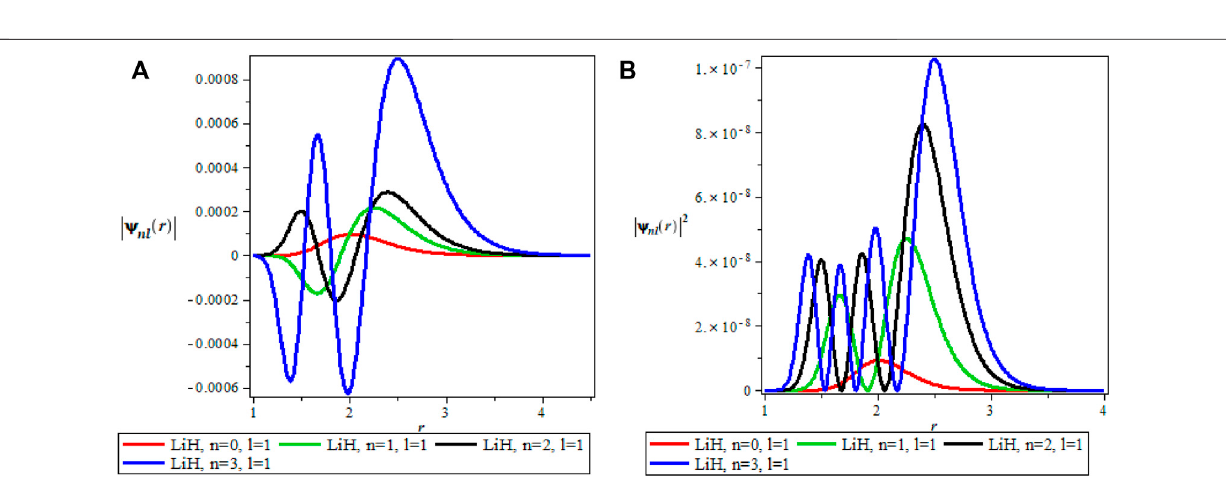
FIGURE 2 | (A) Wavefunction plot for fi xed l = 1 for LiH molecule. (B) Probabilty density plot for fi xed l = 1 for LiH molecule.